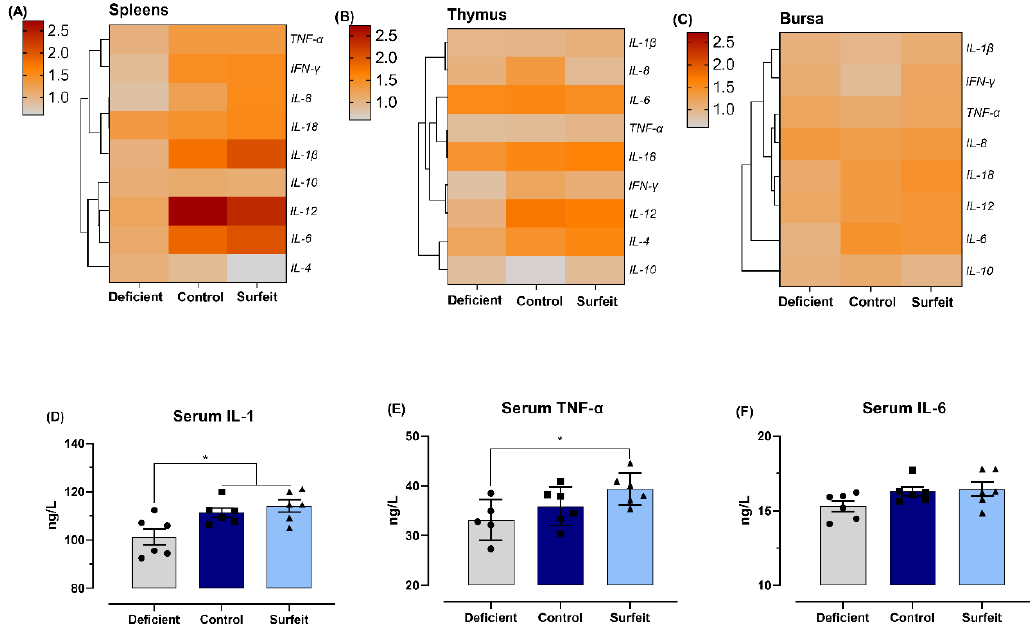
Figure 4. A heat map showing the mRNA expression of inflammatory cytokines in ( A ) spleen, ( B ) thymus, and ( C ) bursa from broilers fed the Mn-deficient, the control, or the Mn-surfeit diets with S . Typhimurium infection at 7 days-of-age. ( D ) IL-1, ( E ) IL-6, and ( F ) TNF- α content in the serum were determined. IL, interleukin; IFN, interferon; TNF, tumor necrosis factor. Data represent means with standard deviation. * p < 0.05.